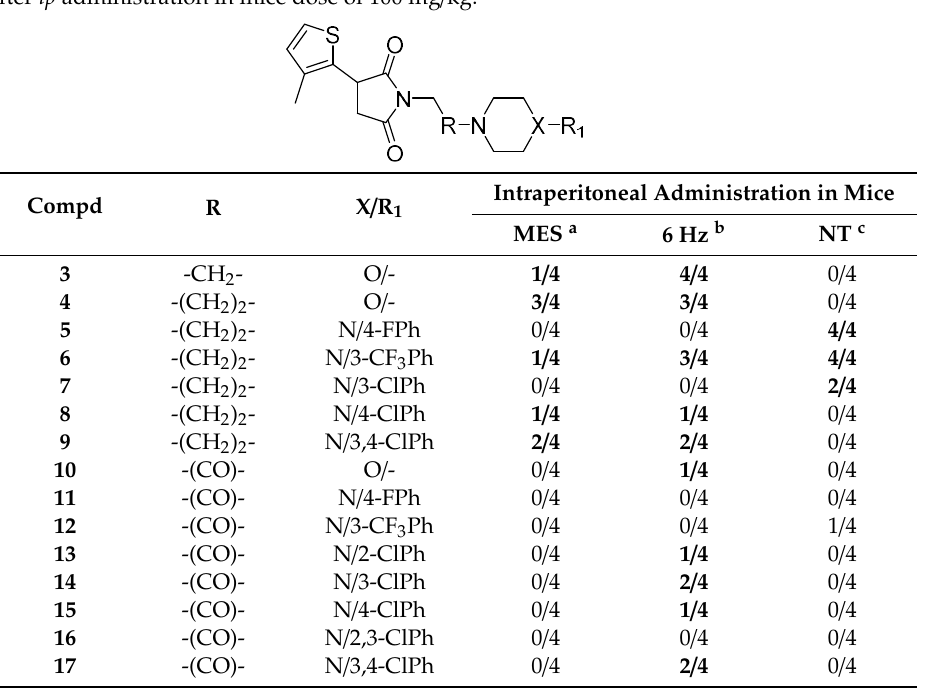
Table 2. Anticonvulsant activity (MES, 6 Hz, sc PTZ) and acute neurotoxicity (rotarod test) following 0.5 h after ip administration in mice dose of 100 mg / kg.